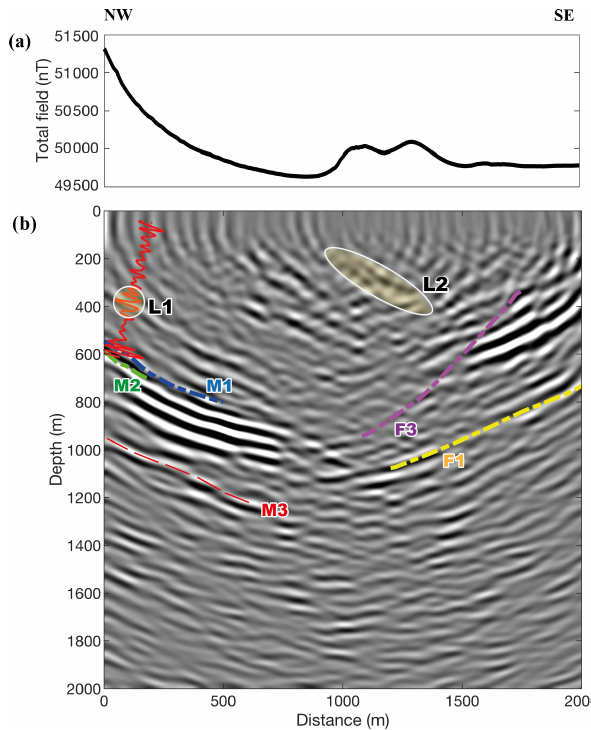
Figure 10. (a) Total-field magnetic anomaly along the seismic sec- tion. (b) The intersections of two deposit surfaces (M1 & M2) and the intersection of the two fault planes (F1 & F2) are plotted. The synthetic trace is plotted along the well trajectory. R1 is interpreted to be from a lithological contact (see Fig. 8). R2 may be a weak iron oxide mineralization as it appears in a region with slightly higher magnetic properties than the neighbouring